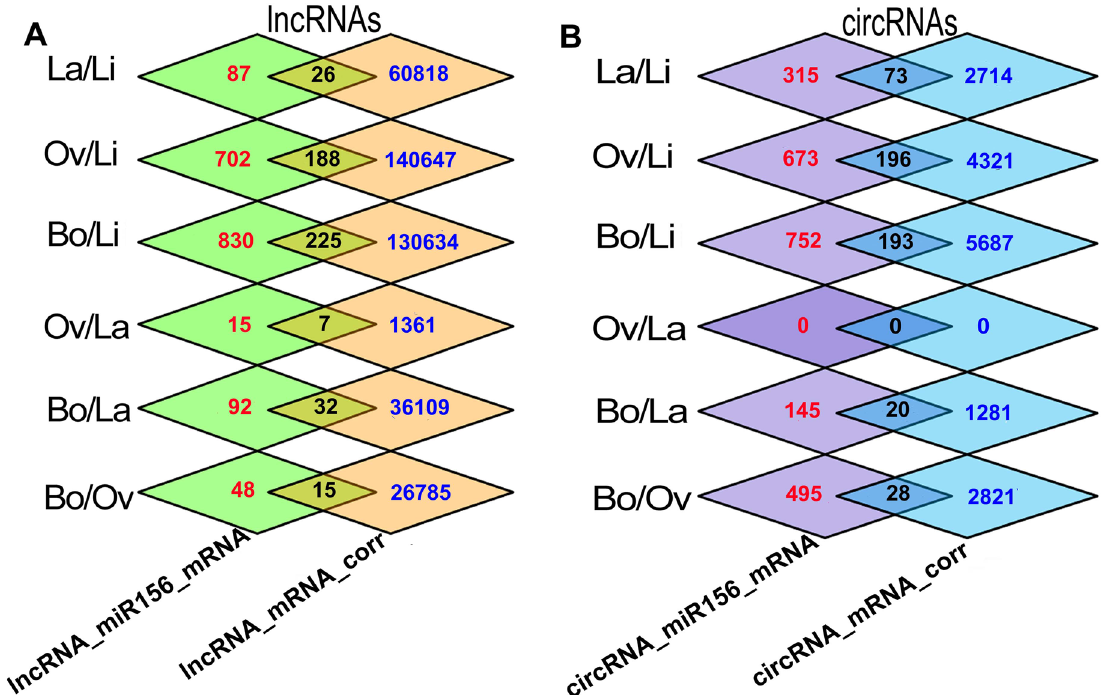
Figure 6. Regulatory relationships in P . hl . lncRNA–miR156–mRNA and circRNA–miR156–mRNA represent the number of lncRNA–mRNA and circRNA–mRNA relationships have same MREs of miR156 respectively. lncRNA–mRNA corr and circRNA–mRNA corr represent the number of lncRNA- mRNA and circRNA–mRNA relationships which showed positive correlations in expression trend. Interaction represents the number of met both two conditions. This figure was generated by